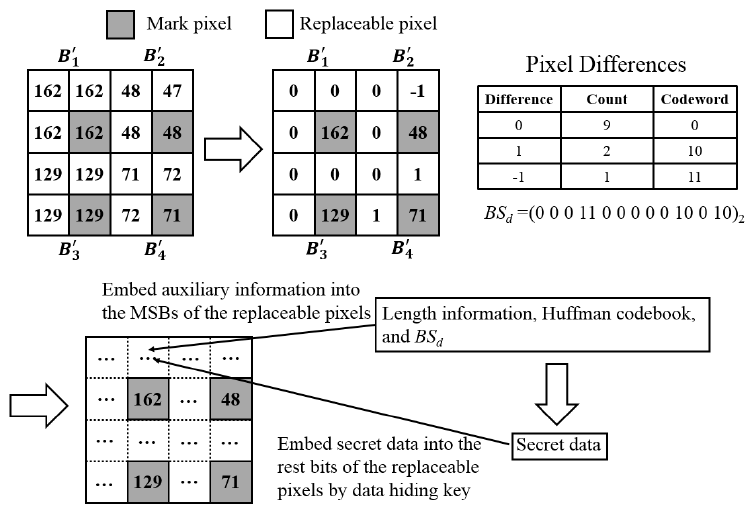
Figure 4. Example of room vacating and data embedding.